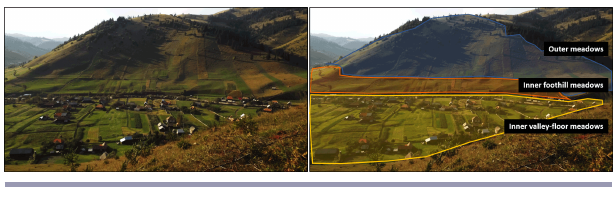
Fig. 3 . Local farmers distinguish between three types of hay meadows, based primarily on their spatial location in the valley and on mountain slopes. Photo: Dániel Babai.